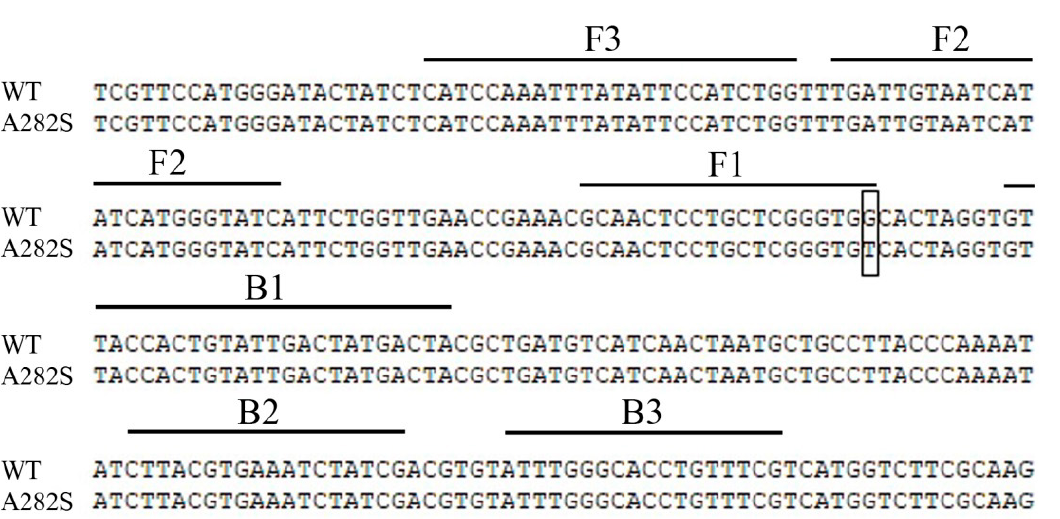
Figure 3. Position of primers for LAMP reaction in CsRDL1 sequence.